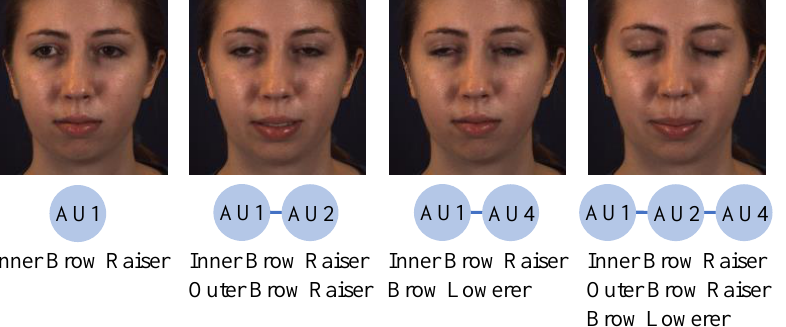
Figure 1. Example images for different action units (AUs) with overlapped regions. If the regions of multiple AUs have overlaps, the appearance of each AU fuses for a new combined